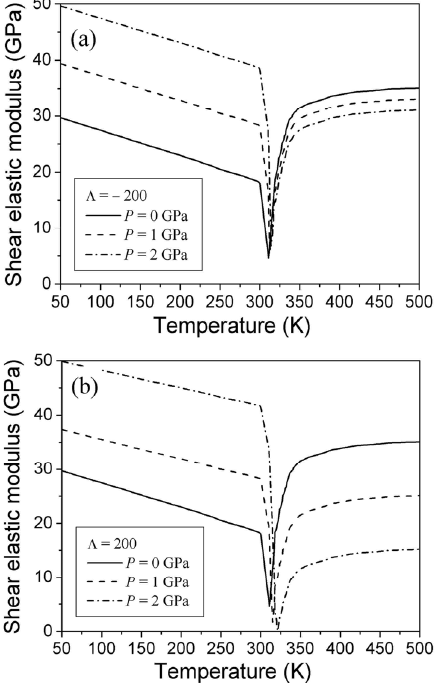
Figure 4. ( a ) Pressure influence on temperature dependence of shear modulus computed for the negative Λ values. ( b ) Pressure influence on temperature dependence of shear modulus computed for the positive Λ